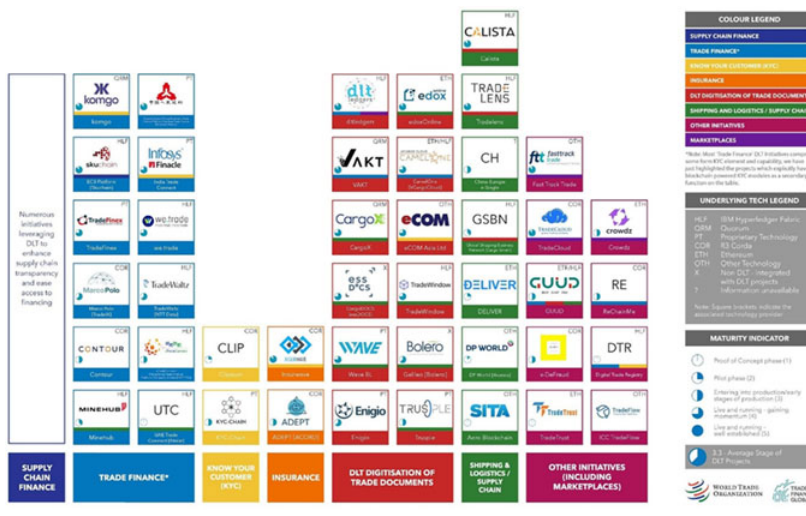
Figure 1: Blockchain project in trade and trade fi nance 3 Source: Ganne and Patel (2020), DLT Projects in Trade: Where Do We Stand?, TFG-WTO